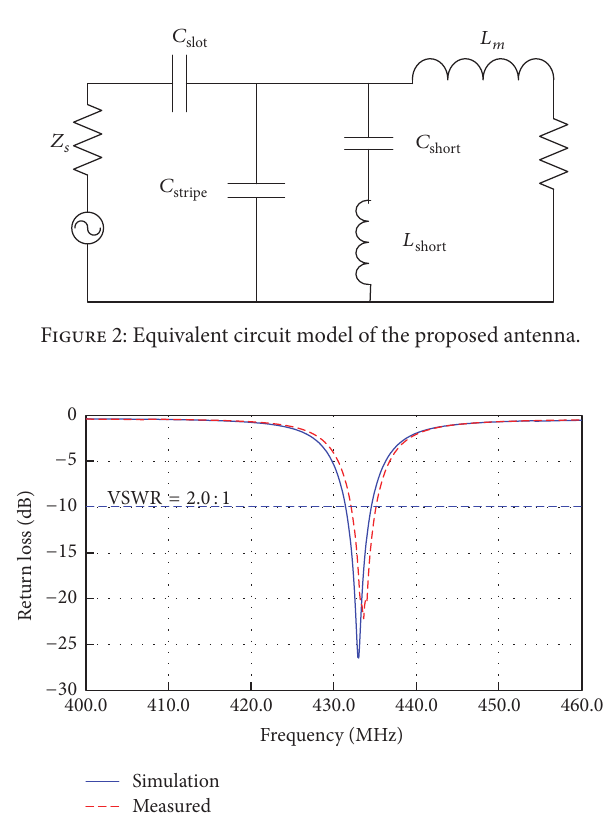
Figure 3: Measured and simulated return losses of the proposed antenna.